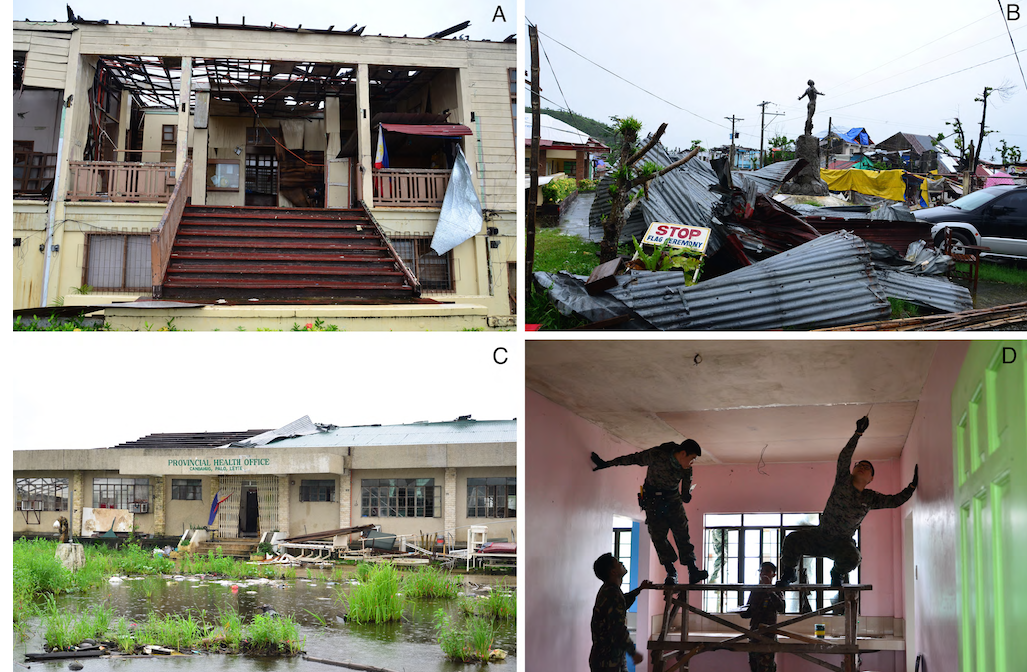
Figure 8. (a, b) Damage observed at the School of Health Science at the University of the Philippines, Manila. (c) Damage to the Provincial Health Office building in Palo. (d) The South Korean army helping with the restoration of a local hospital in